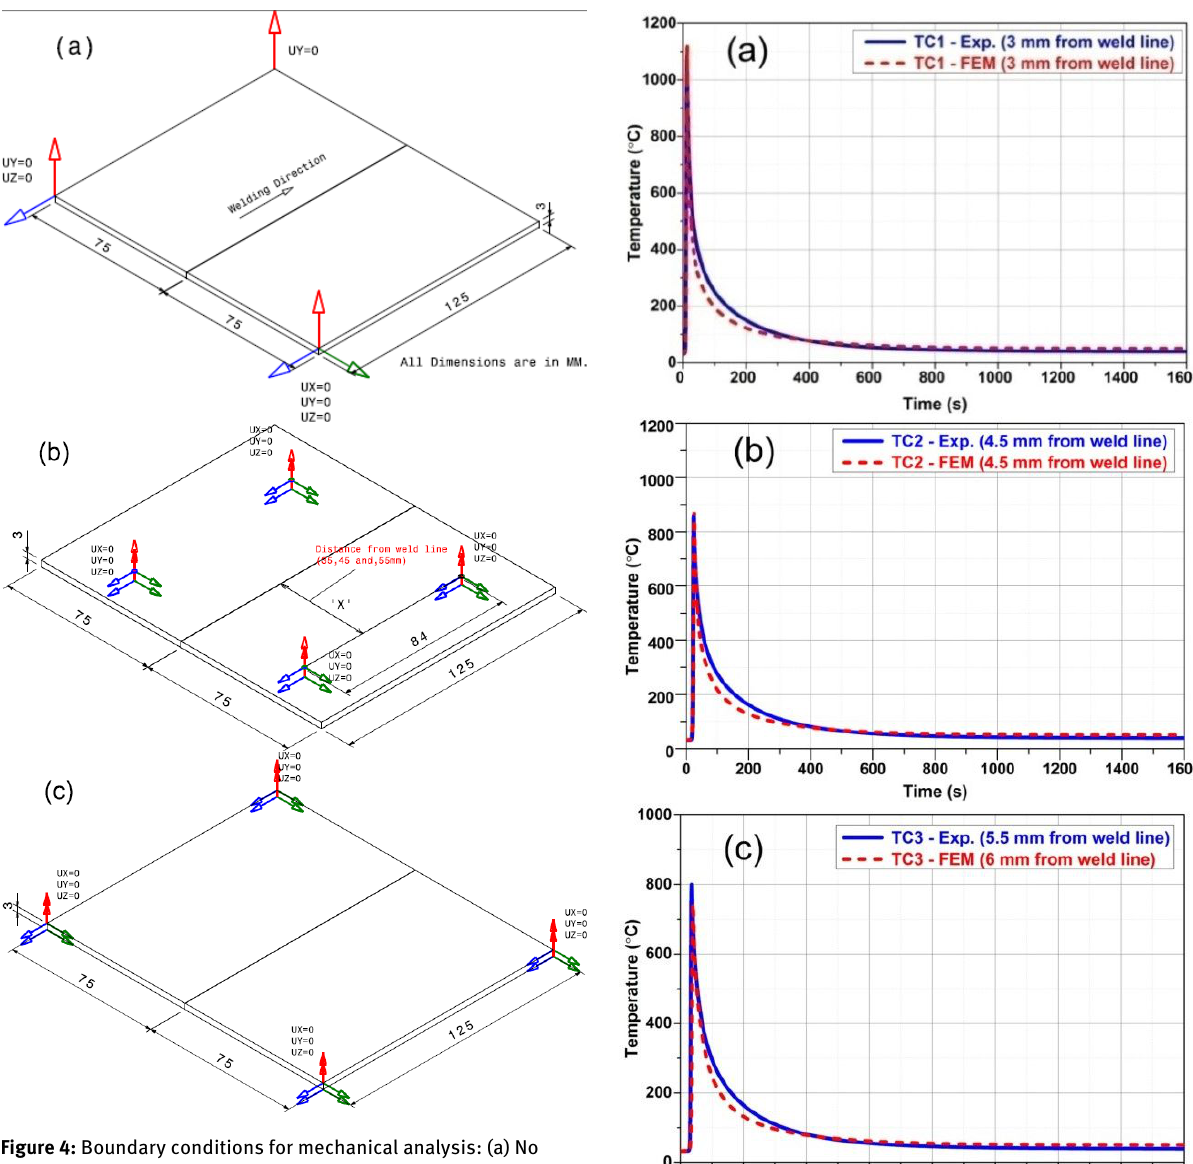
applied at extreme corner nodes at both bottom and top surfaces of the